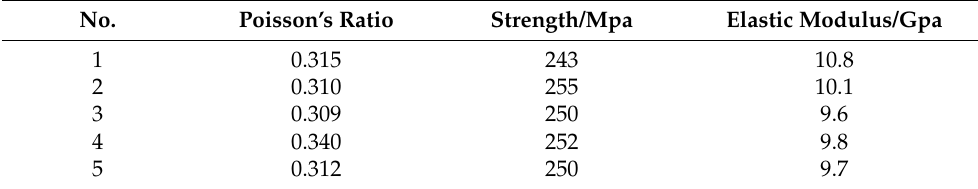
Table 1. Tensile test